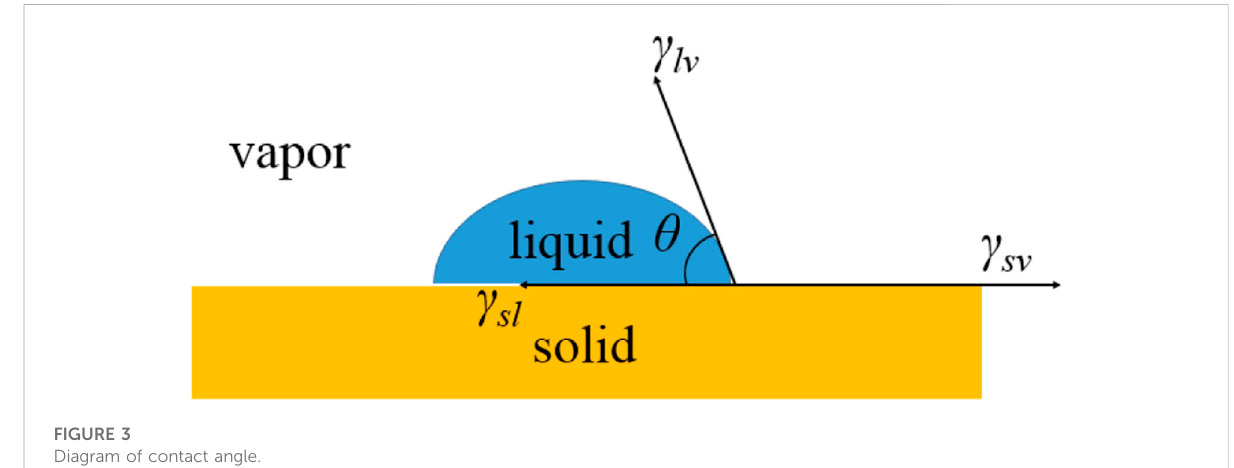
FIGURE 3 Diagram of contact angle.